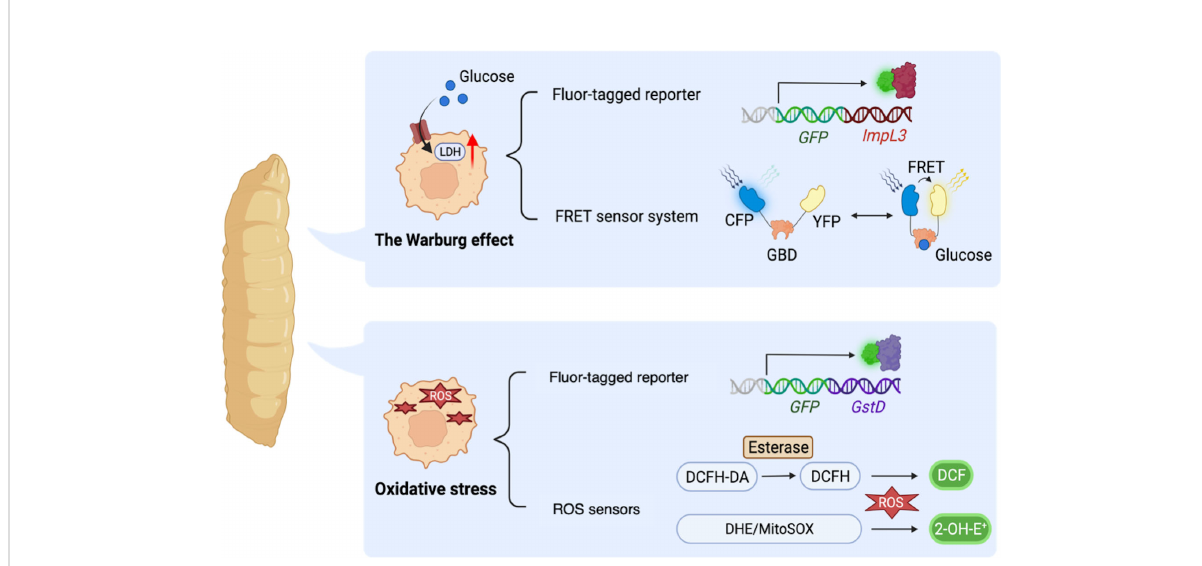
FIGURE 3 Drosophila methodologies to monitor metabolic alterations in a whole-body manner. ImpL3 - GFP : a GFP-based enhancer trap reporter strain which enables easy detection of endogenous ImpL3 expression in fl y tissues. Förster resonance energy transfer (FRET)-based glucose sensor: a reporter strain carrying a glucose-binding domain (GBD), cyan fl uorescent protein (CFP), and yellow fl uorescent protein (YFP). FRET sensor determines the intracellular glucose level upon binding of glucose to GBD, which in turn changes the GBD ’ s structure to increase the FRET ef fi ciency (the ratio of YFP to CFP). GstD - GFP , a GFP-based endogenous GstD expression reporter strain to monitor oxidative stress response. DCFH-DA, 2 ′ ,7 ′ -Dichloro fl uorescin diacetate, a cell-permeable ester that can be hydrolyzed intracellularly by esterases to become DCFH which reacts with H 2 O 2 and turns into highly fl uorescent DCF. DHE, dihydroethidium which forms a highly fl uorescent product 2-hydroxyethidium (2-OH-E + ). MitoSOX, a DHE derivative with an additional triphenylphosphonium group to target mitochondria monitoring ROS within